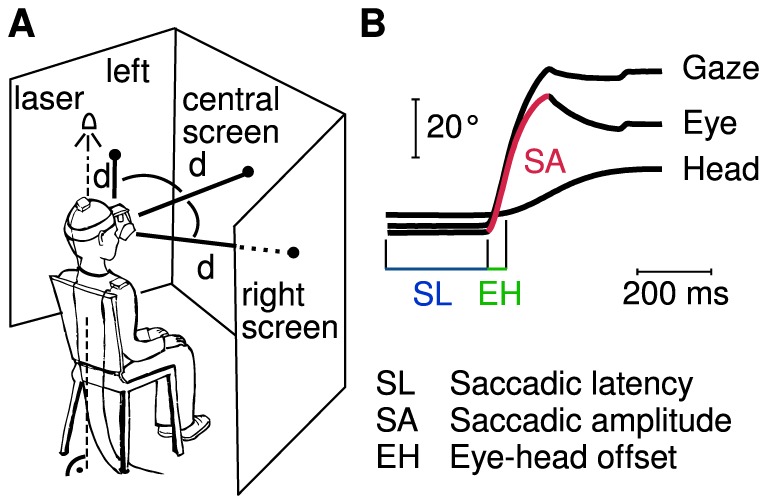
(A) Visual targets appeared at three positions (illustrated by black dots): on the left, central, and right screens.All three target positions had viewing distances of d = 80 cm. A horizontal laser was used for correct subject positioning. The peripheral targets appeared at 55° to the left and right of center. (B) A typical gaze shift with eye and head contribution. Main parameters detected were saccadic latency (SL), saccadic amplitude (SA) and eye-head offset (EH). Reprinted from www.jemr.org
[49] under a CC BY license, with permission from the Journal of Eye Movement Research, original copyright 2012.